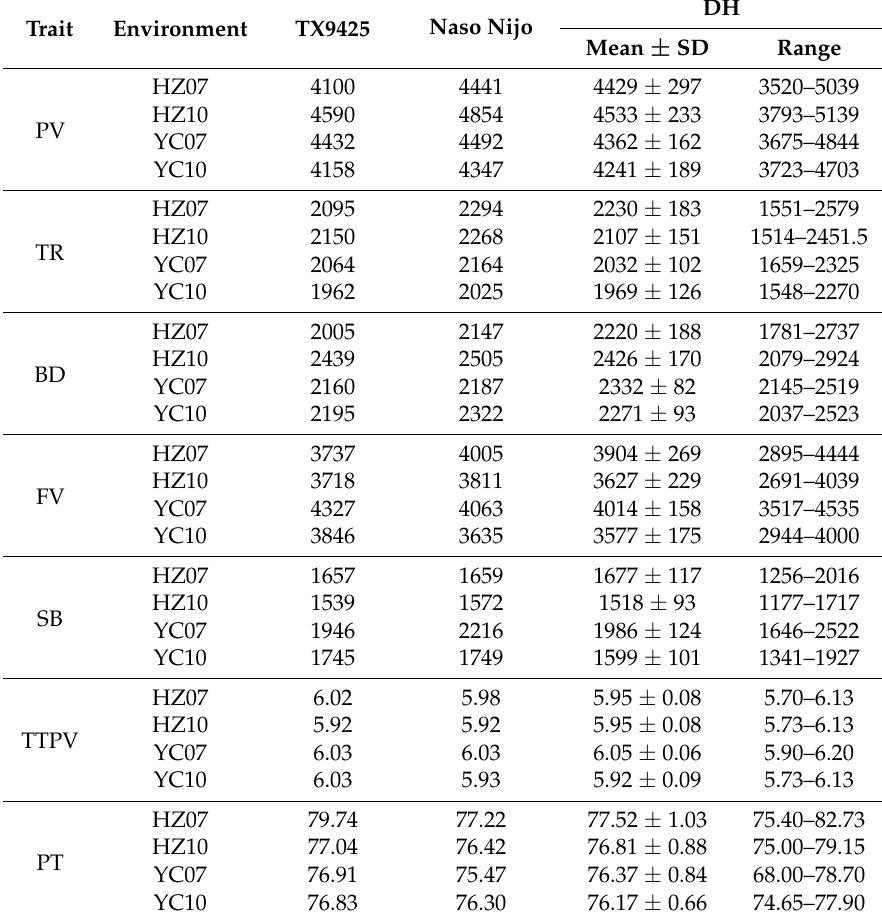
Table 1. Mean and range of pasting properties tested in different